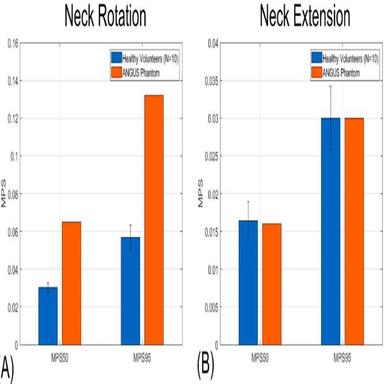
The 50th and 95th percentile of maximum principal strain (MPS50 and MPS95, respectively) for healthy volunteers (after scaling) and the ANGUS phantom during (A) neck rotation and (B) neck extension experiments.